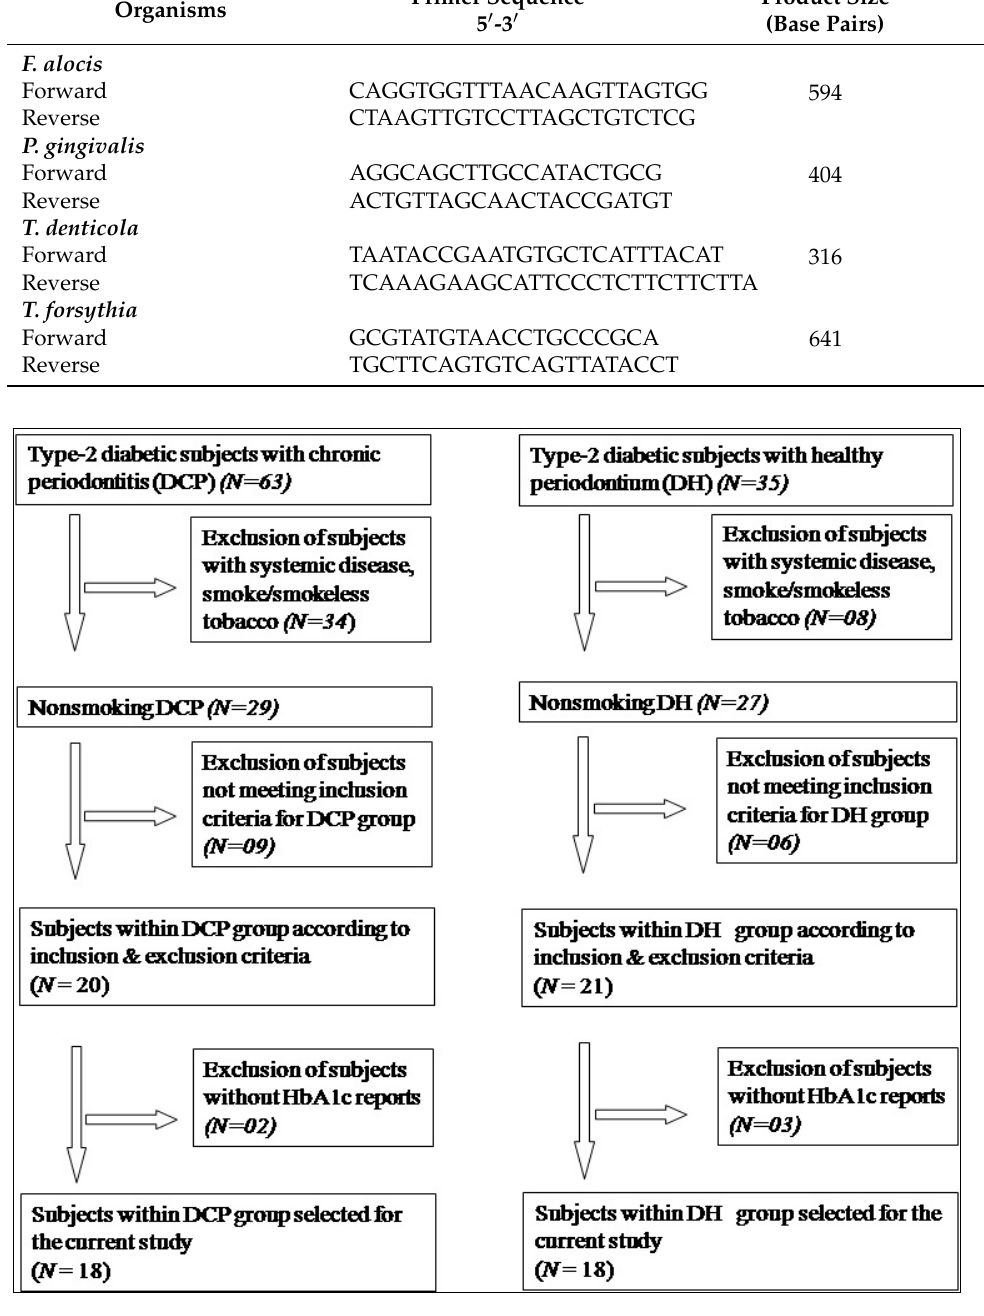
Figure 1. Flow diagram for the selection of type 2 DM patients with chronic periodontitis (DCP) and healthy periodontium (DH) according to the inclusion and exclusion criteria. Table 1. Primer sequences used for the DNA amplification of F. alocis and red complex bacteria.